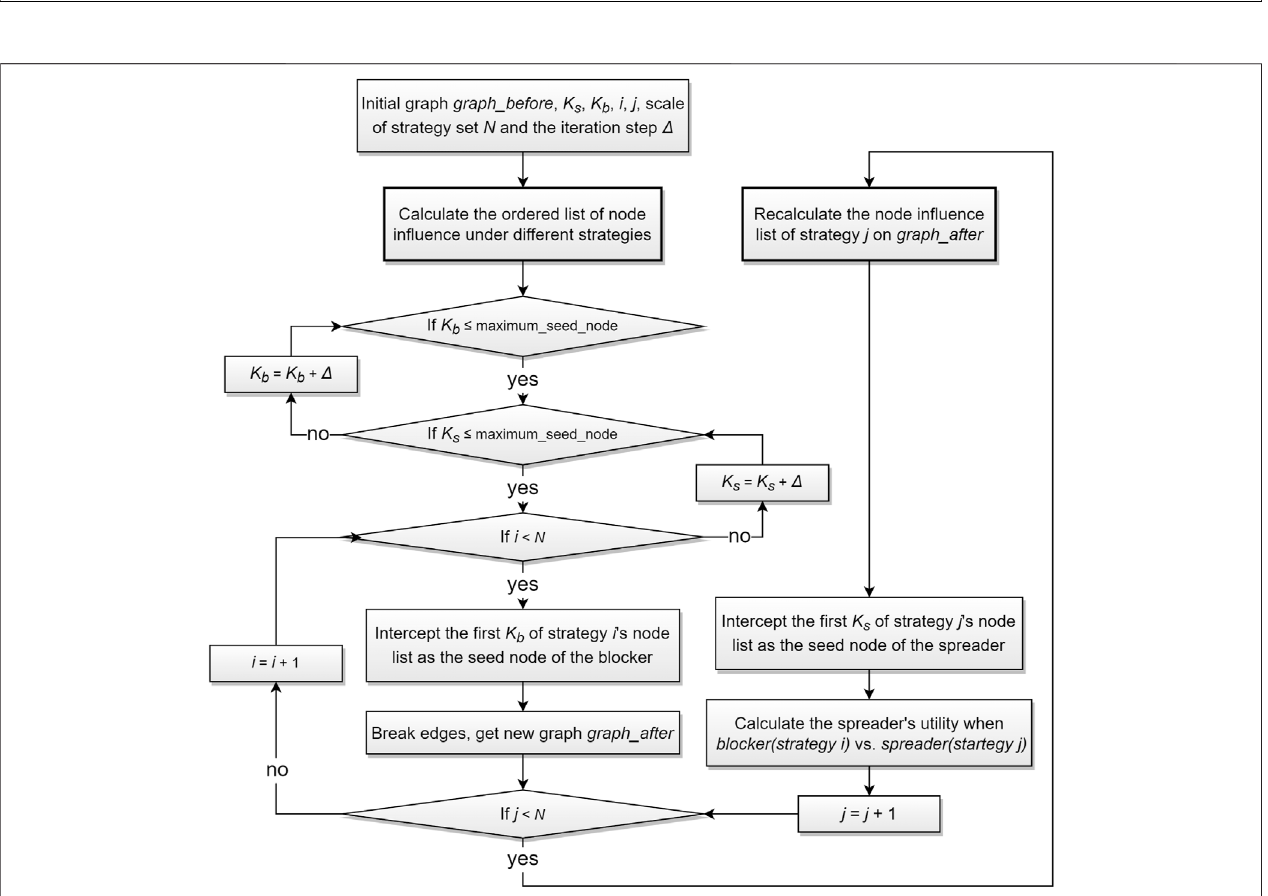
FIGURE 2 | The algorithm diagram of calculating the utility matrix of the